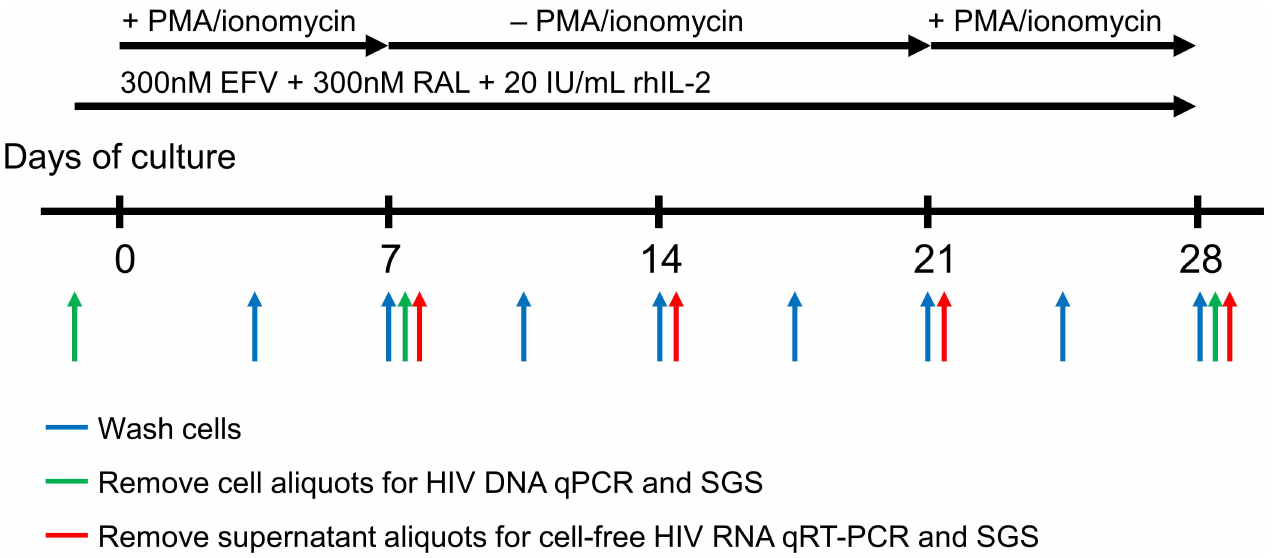
Fig 1. Experimental systemschematic. PBMC or purifiedtotal CD4 + T-cells were cultured with 300 nM efavirenz (EFV), 300 nM raltegravir (RAL), and 20 IU/mL of recombinanthuman IL-2 (rhIL-2). Cells were sequentially stimulatedwith PMA (50 ng/mL) and ionomycin(500 ng/mL). The stimulationdurationwas seven days with an inter-stimulation periodof fourteen days. Cells were washedtwice weekly. Aliquotsof cells from blood and from ex vivo cultures on days -1, 7, 21, and 28 were saved for HIV DNA qPCR and/or single-genome sequencing (SGS). Aliquots of supernatantwere removedonce weekly for virion-associatedHIV RNA qRT-PCR and SGS.